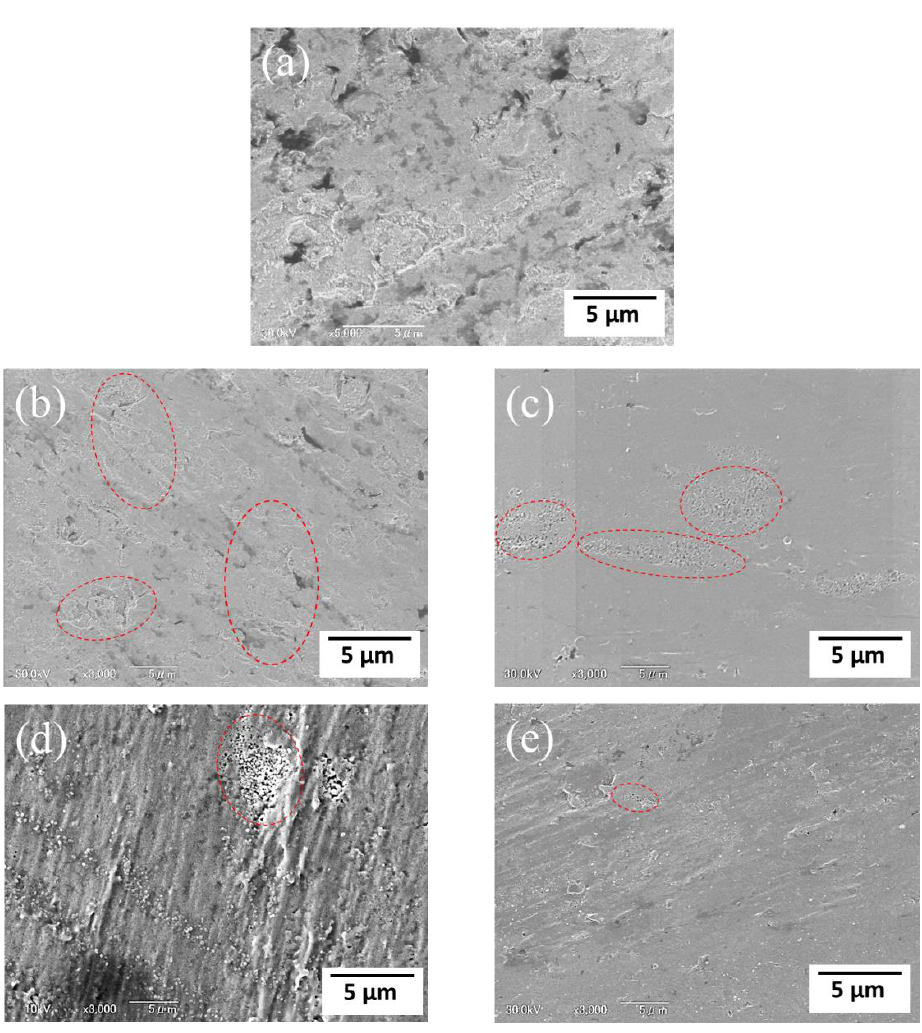
Figure 10. SEM images of uncoated titanium ( a ) and DLC films deposited at CH4/H2 = 1:1, 6 h ( b ); CH4/H2 = 1:1, 12 h ( c ); CH4/H2 = 1:0, 6 h ( d ); CH4/H2 = 1:0, 12 h ( e